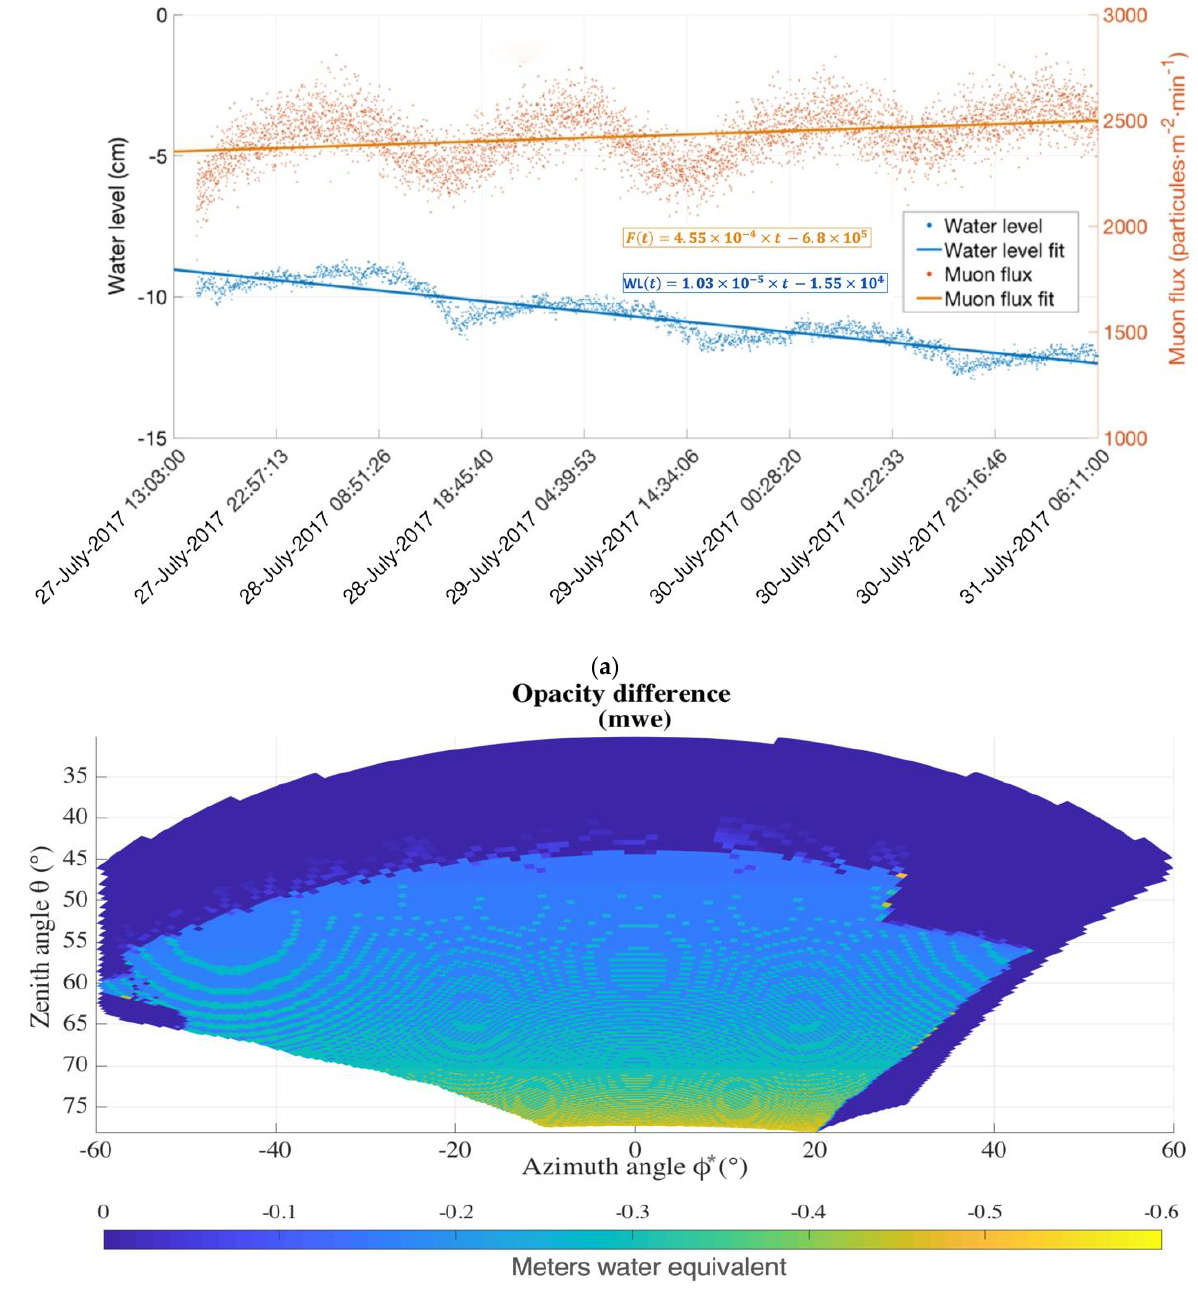
Figure 6. ( a ) Temporal evolution of (blue) water level of the dam and (orange) recorded muon flux and ( b ) change of apparent opacity of the medium due to the water transfer between the beginning and the end of the data acquisition.